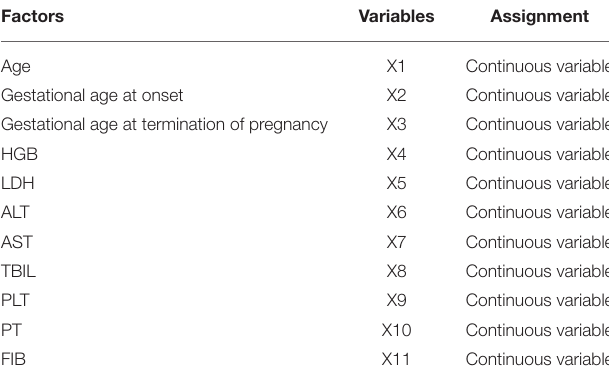
TABLE 4 | Assignment for multivariate analysis of